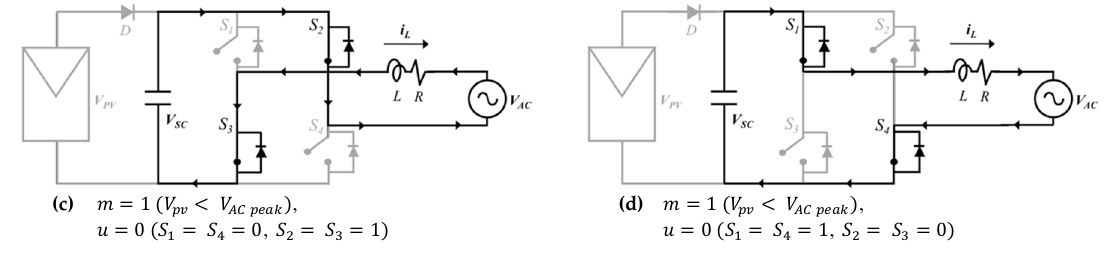
Figure 2. Equivalent electric circuits.